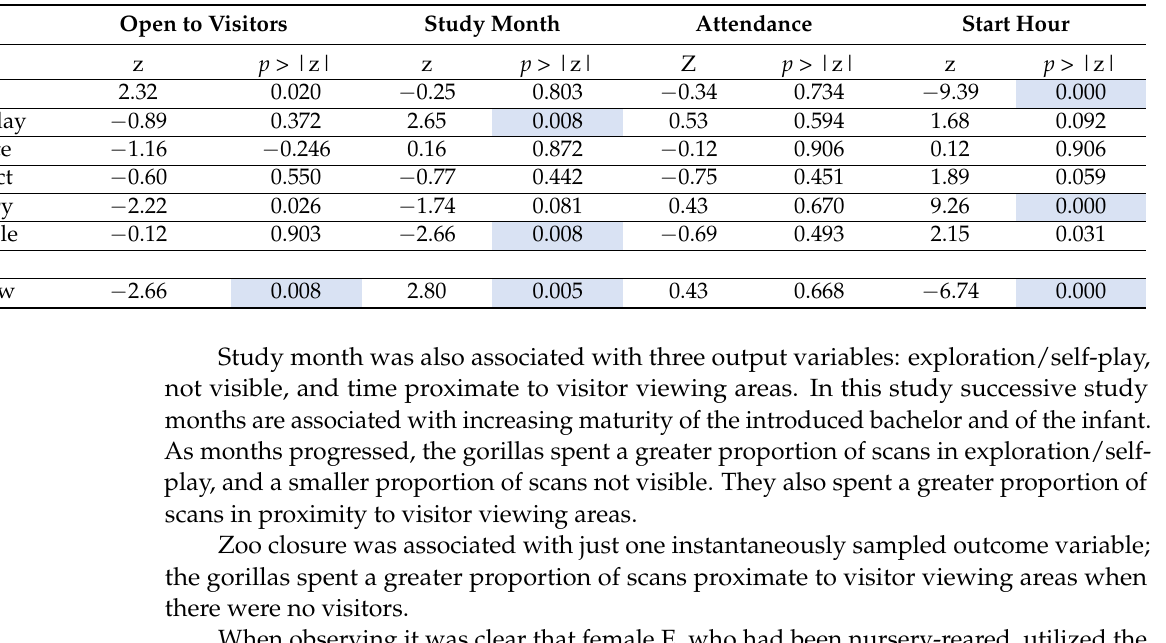
Table 3. Mixed-effect negative binomial regression associations between input variables and measures of activity and location close to visitor viewing areas. Variables significantly associated with output measures are shaded in